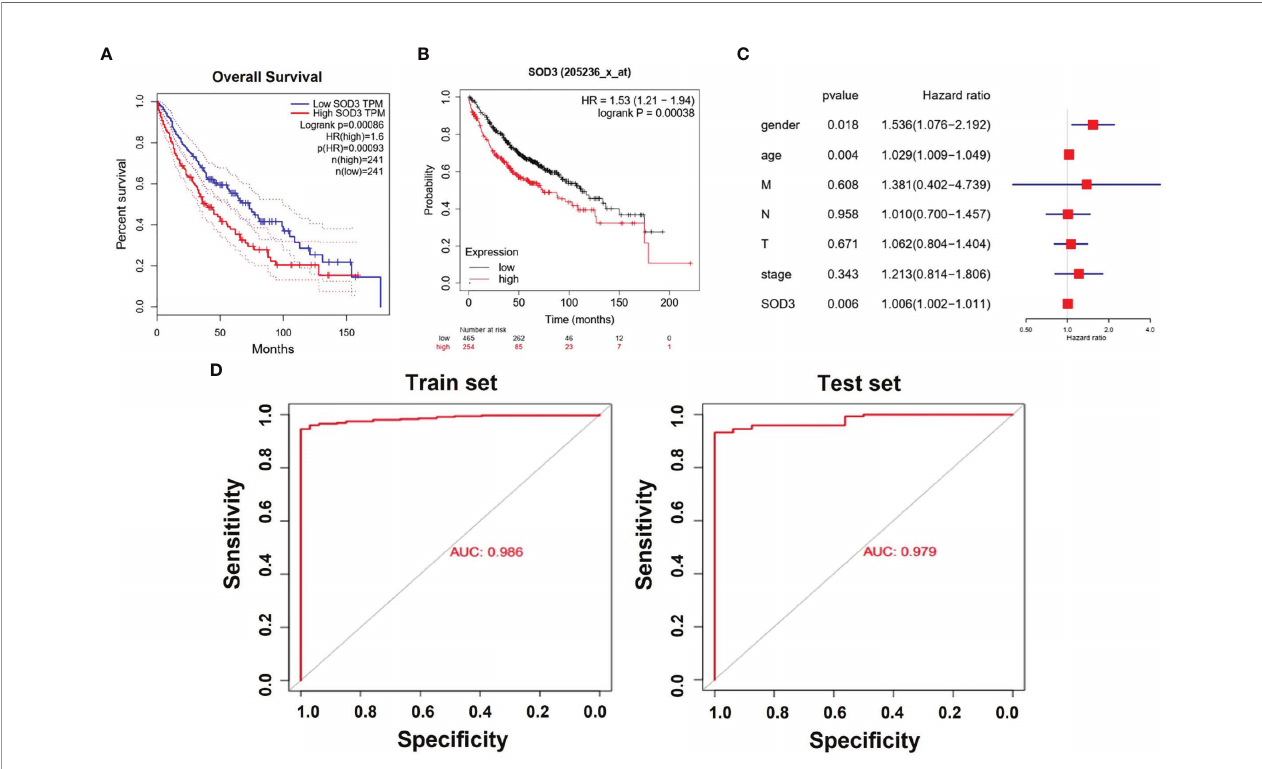
FIGURE 2 | (A) Kaplan – Meier curves for survival probability in l LUSC. High SOD3 expression was related to poor survival probability. (P = 0.00086). (B) Kaplan – Meier curves for survival probability in l LUAD. High SOD3 expression was related to poor survival probability. (P = 0.00038. (C) Multivariate analysis of GEO database. HR>1 can be used as an independent risk factor. (D) The Areas under ROC curve of train group and test group by classi fi cators